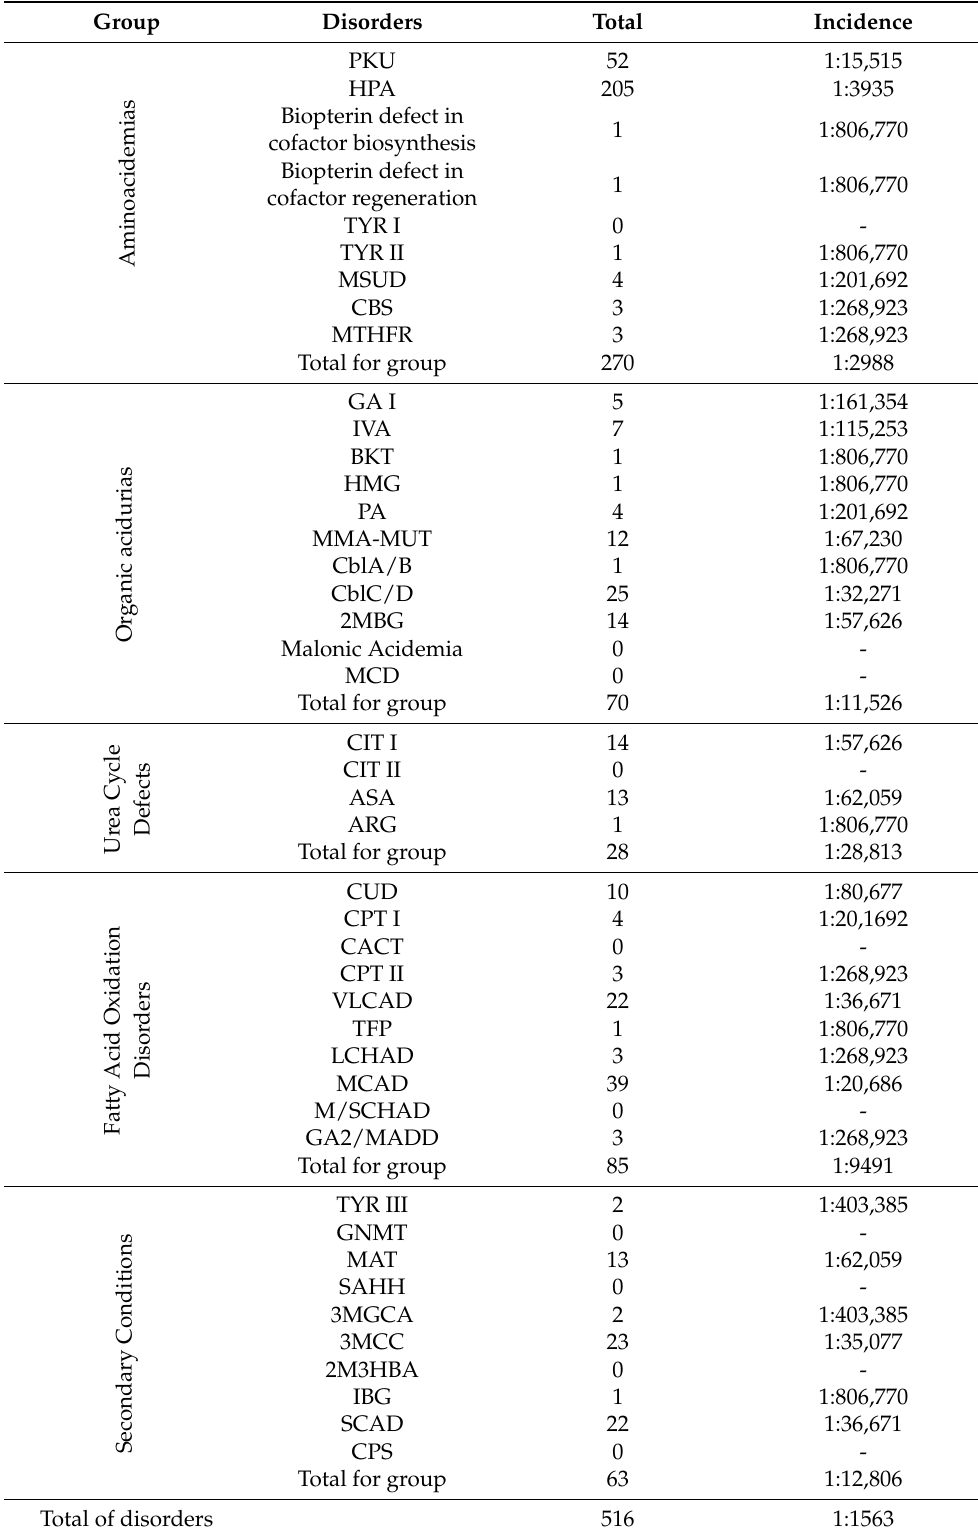
Table 3. Diagnoses identified by expanded NBS in Italy between 1 January 2019 and 31 December 2020. 806,770 newborns were